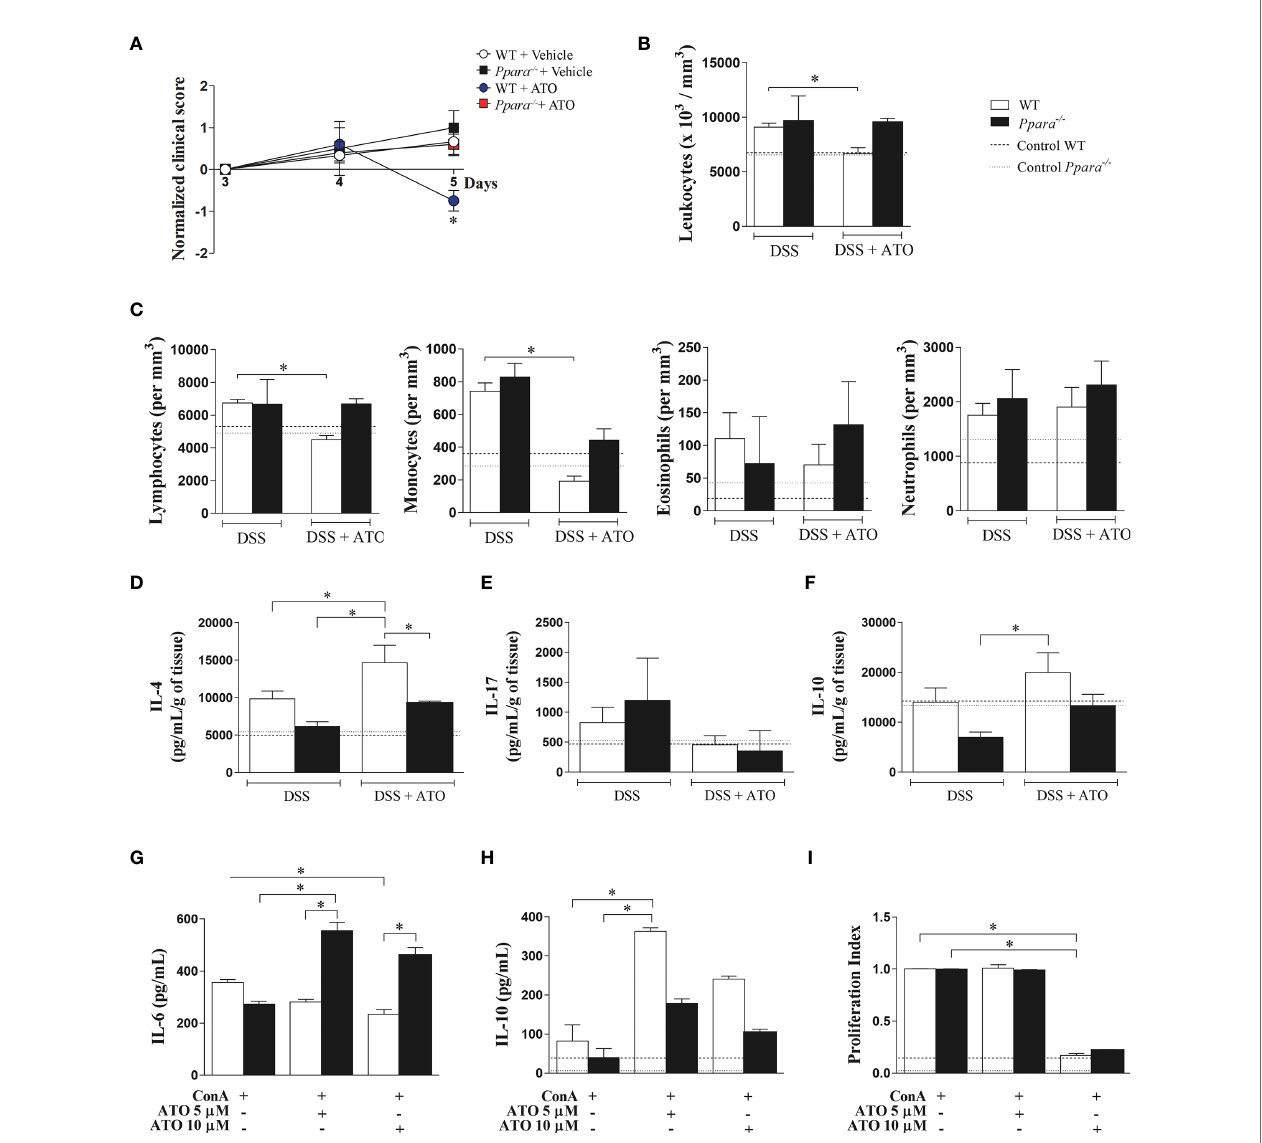
FIGURE 6 | PPAR- a de fi ciency abrogates the ATO-mediated effects in both experimental colitis and ConA-stimulated splenocytes in vitro . (A) WT and Ppara -/- mice were exposed to 3% (w/v) DSS in drinking water for 6 days. Mice received oral treatment once daily for three days (days 3-5) with saline (vehicle) or 10mg/Kg/ day of ATO. In (B) total number of circulating white blood cells (leukocytes) and (C) differential leukocyte counts. (D-F) Quanti fi cation of IL-4 (D) , IL-17 (E) and IL-10 (F) levels in colon tissue lysates. (G – I) Splenocytes from C57BL/6 WT and Ppar -/- naïve mice were stimulated with 3 µg/mL ConA and concomitantly treated with 5 or 10 µM of ATO for 72h. IL-6 (G) and IL-10 (H) cytokines quanti fi cation in the supernatant was performed by ELISA. The proliferation of CFSE-stained cells was evaluated by fl ow cytometry and expressed as proliferation index (I) . The dashed lines indicate values from healthy control WT or Ppara -/- mice without colitis induction or unstimulated cells. These results in A-F are representative of 3 independent experiments with 5 mice per group. The data from graphs G-I are representative of 2 independent experiments that were performed, each one, with splenocytes pooled from 3 WT or Ppara -/- mice. ANOVA test was used followed by Tukey comparison or Kruskal – Wallis (Dunns) test to determine if differences attained signi fi cant response. *p < 0.05. ATO, Atorvastatin; ConA, Concanavalin A; DSS, Dextran sodium sulfate; LP, Lamina propria; MLN, Mesenteric lymph nodes; PPAR- a / Ppara , Peroxisome proliferator-activated receptor alpha; WT, wild